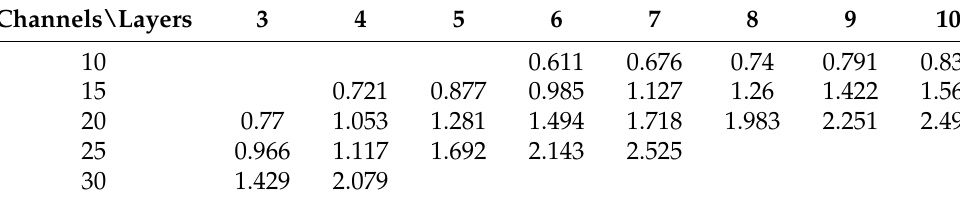
Table 8. Power consumption estimation charts.